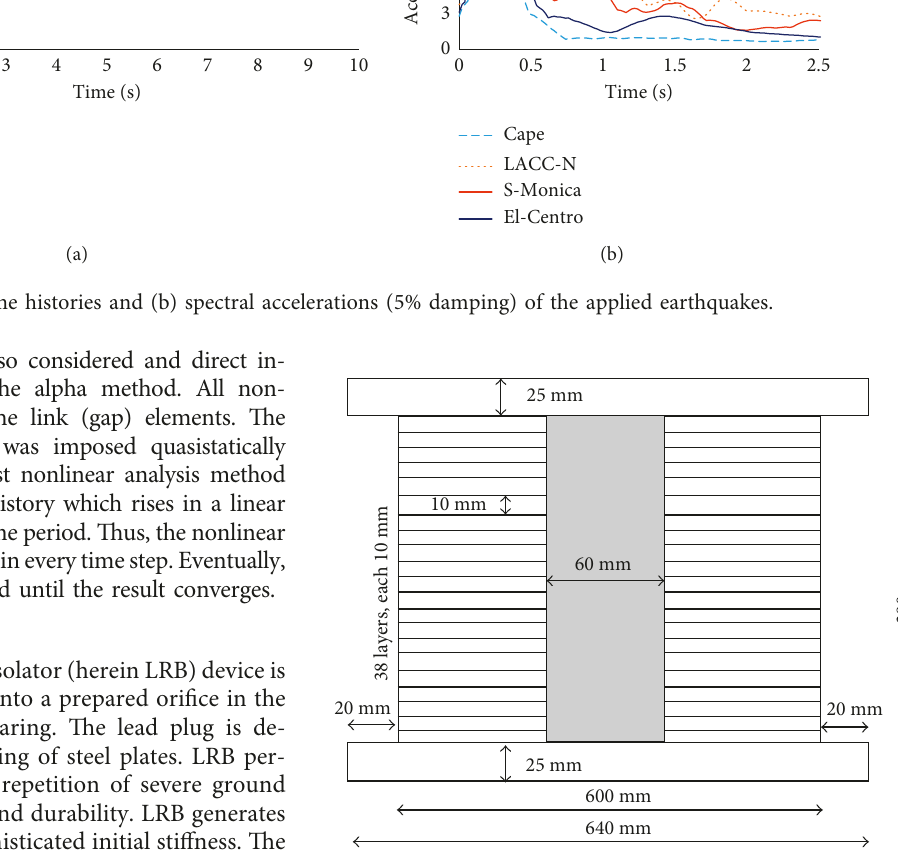
Figure 2: LRB details used in this